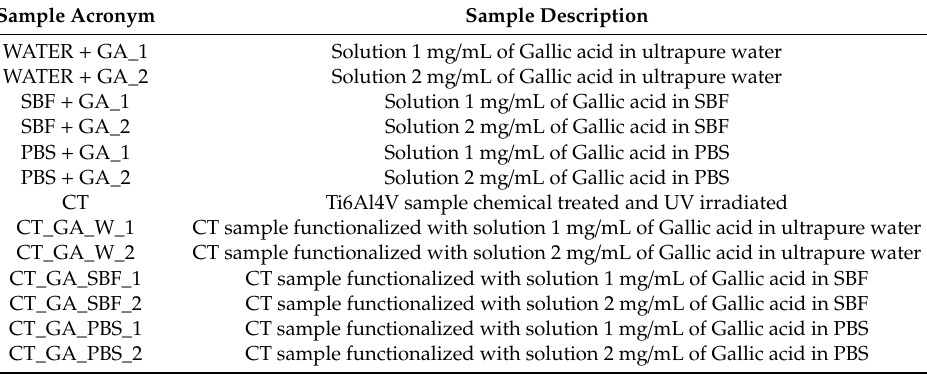
Table 1. Acronyms and a brief description of the source solutions and of the functionalized samples. Sample